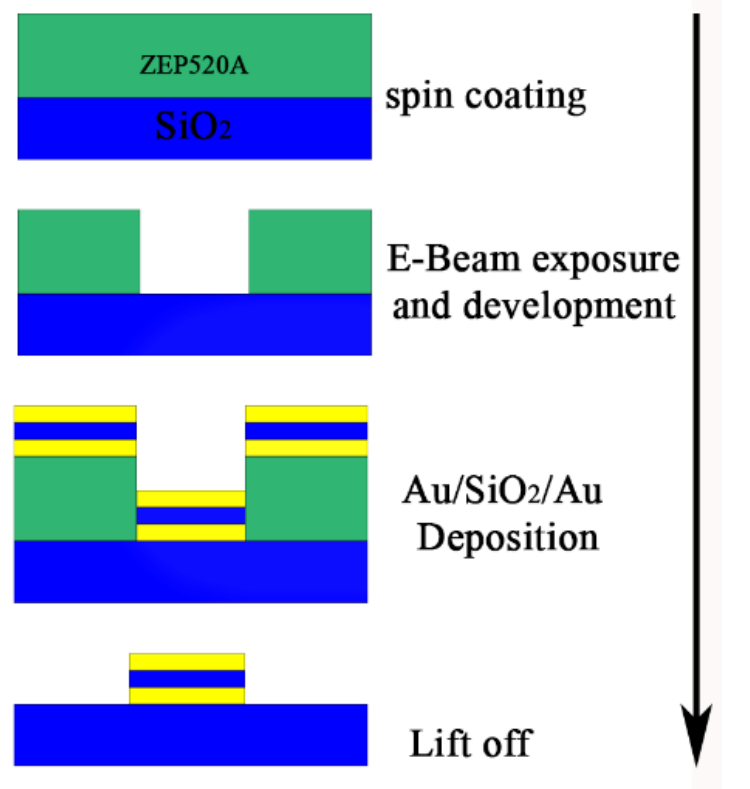
Figure 2. Schematic illustration of the fabrication process of Au/SiO 2 /Au MIM nano-discs.